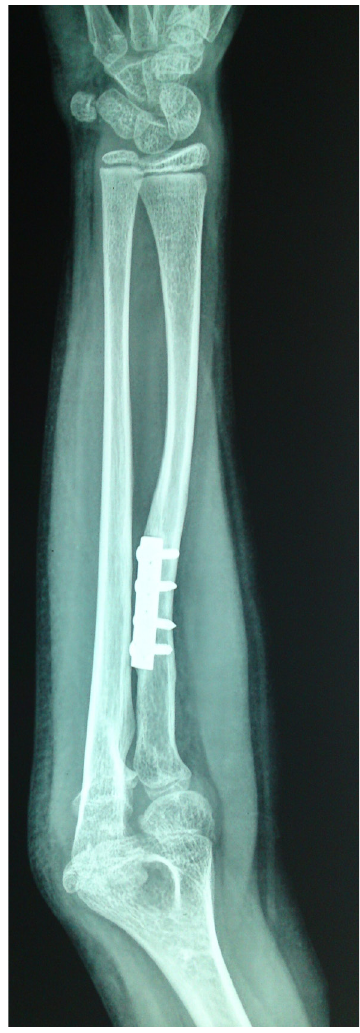
Figure 2. Immediate post-operative X-ray with radial shortening and fixation with plate and screws. The radial bow is corrected. The radial head is fixed with a transarticular pin. Figure 3. One year follow up showing remodeling of the radial